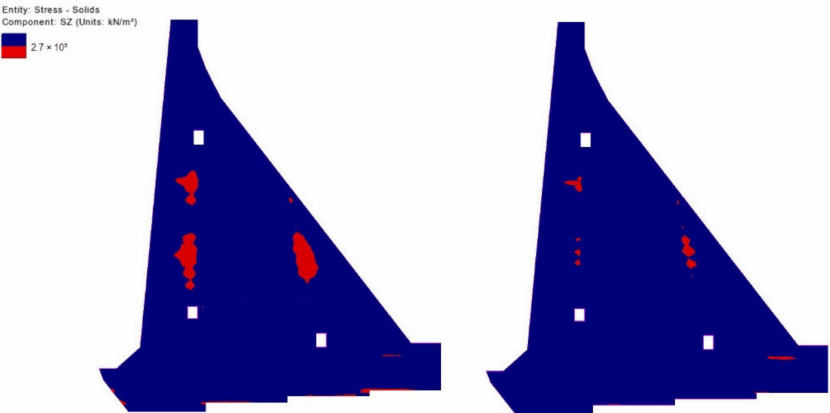
Figure 30. Zones in which the concrete tensile resistance is exceeded (red) in the mid-plane of the monolith 20 m long ( left ) and 15 m long ( right ) for the 1080th day from the beginning of construction (2nd of October of the fourth year).